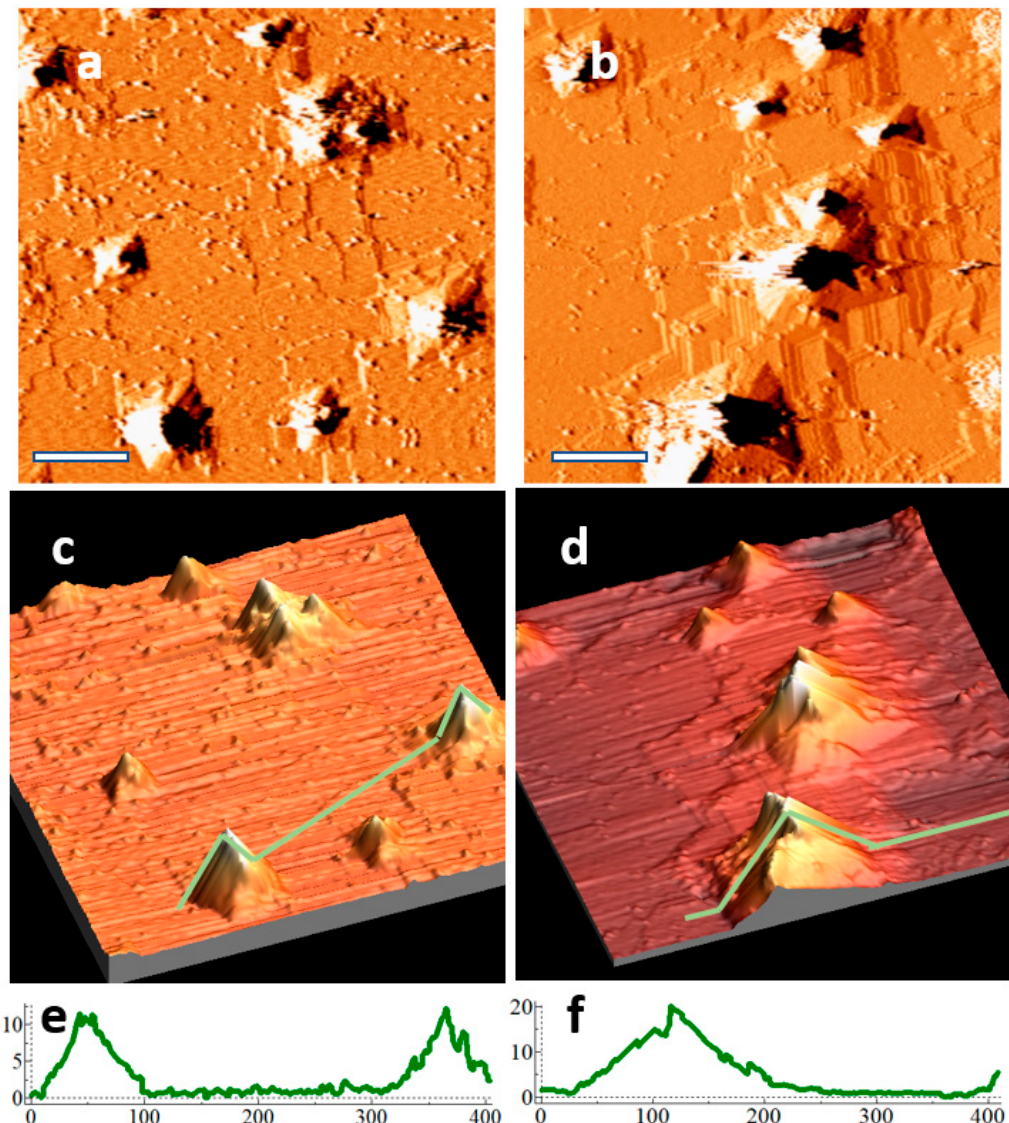
Figure 4. ( a ) STM derivative image of a bare Ge (110) sample in a Ag-coated sample holder after 14 cleaning cycles, fluence 5.1 × 10 17 cm − 2 ; ( b ) STM derivative image of the same sample after 27 cleaning cycles, fluence 9.9 × 10 17 cm − 2 ; ( c , d ) 3D views of ( a , b ), respectively, with associated line profiles along the green lines shown in ( e , f ), respectively. The step density of the substrate was higher on the sample that underwent more cleaning cycles. The location of steps near the pyramids supports two hypotheses: (1) pyr- amids inhibit local terrace removal, and (2) a component of pyramid growth is through pinning of step edges at the pyramid’s base. Even though the step edges form {17 15 1}